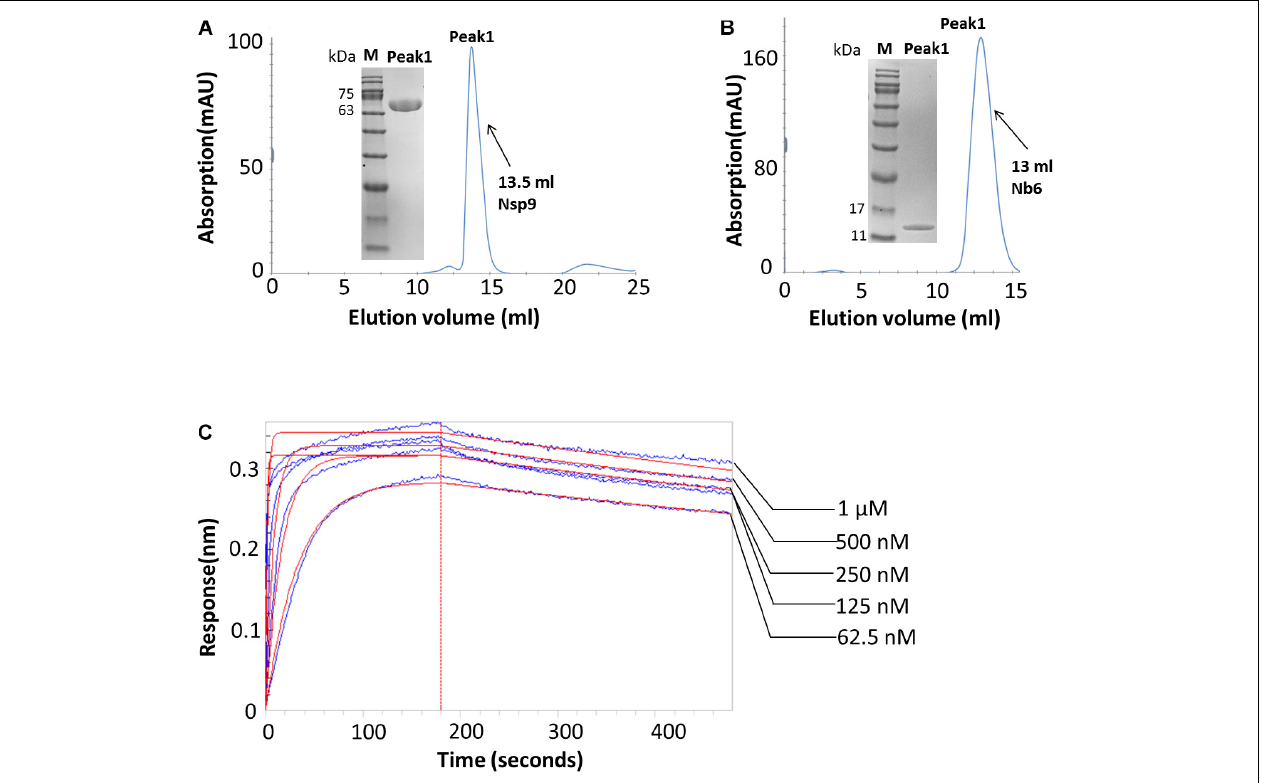
FIGURE 1 | Expression and analysis of recombinant Nsp9 and Nb6. (A) Size-exclusion chromatography of recombinant Nsp9 on calibrated Superdex 200 increase 10/300 GL column. The target protein was eluted at a retention volume of 13.5 ml, corresponding to approximately 72 kDa as monomer. Characterization of recombinant Nsp9 after two-step purification was analyzed by SDS–PAGE (Inset), M: protein ladder (10–180 kDa, Sorlarbio, Beijing, China), Gel: 12% precast polyacrylamide gel (Item No. NP0341BOX, Thermo Fisher Scientific). (B) Size-exclusion chromatography of recombinant Nb6 on calibrated Superdex 75 10/300 GL column. The target protein was eluted at a retention volume of 13 ml, corresponding to approximately 15 kDa as monomer. Characterization of recombinant Nb6 after two-step purification was analyzed by SDS–PAGE (Inset), M: protein ladder (10–180 kDa, Sorlarbio, Beijing, China), Gel: 12% precast polyacrylamide gel (Item No. NP0341BOX, Thermo Fisher Scientific). (C) Analysis of purified Nb6 binding to Nsp9. Gradient concentrations (62.5 nM–1 µ M) of Nb6 in PBS buffer (pH7.4), containing 0.02% tween-20 and 0.1% BSA were passing through the streptavidin biosensor loaded with biotinylated Nsp9, and the signals were